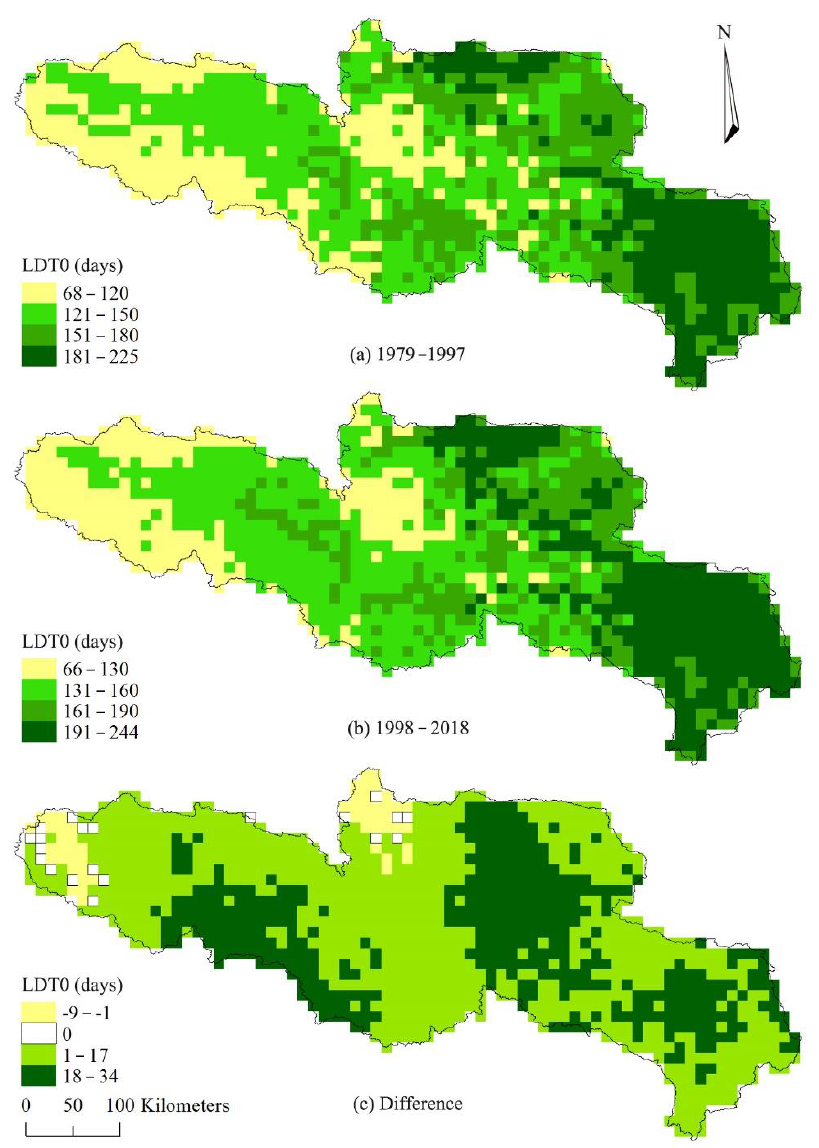
Figure 9. The distribution of averaged lasting days of ≥ 0 °C annual accumulated temperature before ( a ) and after ( b ) 1997 and the difference ( c ) in the source region of the Yellow River.